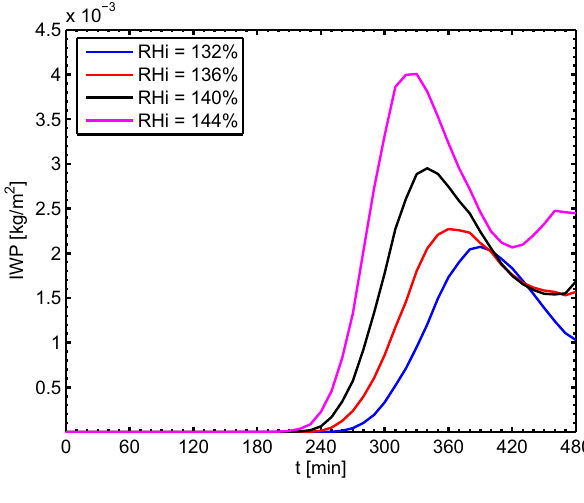
Fig. 9. Mean ice water path IWP (averaged over all columns) of simulations using different initial values for RHi inside the ISSR (RHi=132 to 144%). The black line represents the reference